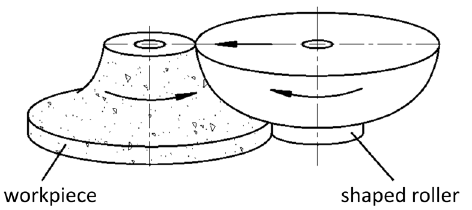
Figure 1. Forming the working surface of a grinding wheel.